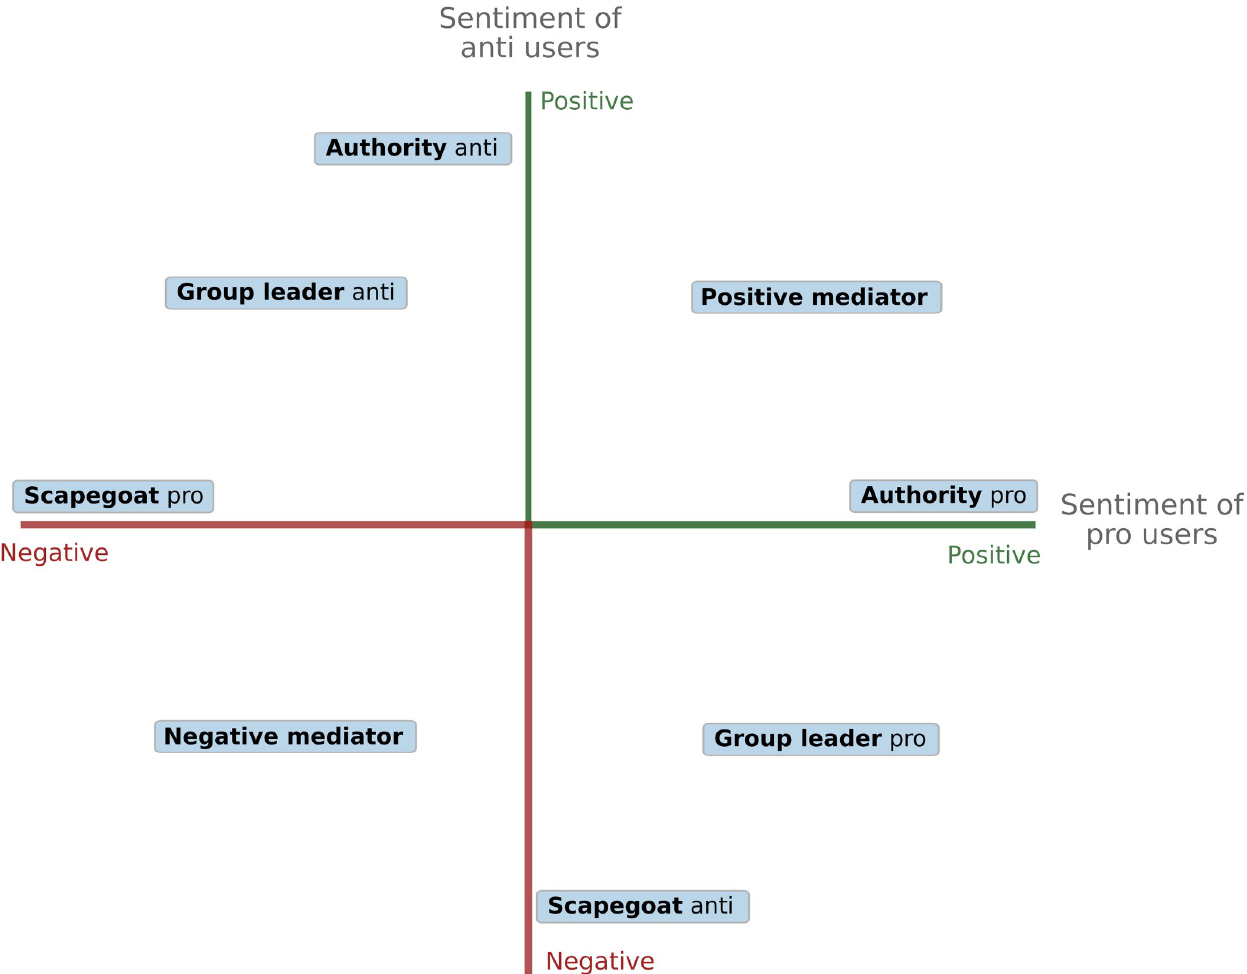
Fig 10. User typology in sentiment landscape. Theoretical landscape of positions in the debate, as defined by the way users of both sides (pro and anti) reference the users. The x-axis and y-axis represent the average sentiment of pro- and anti-users, respectively.